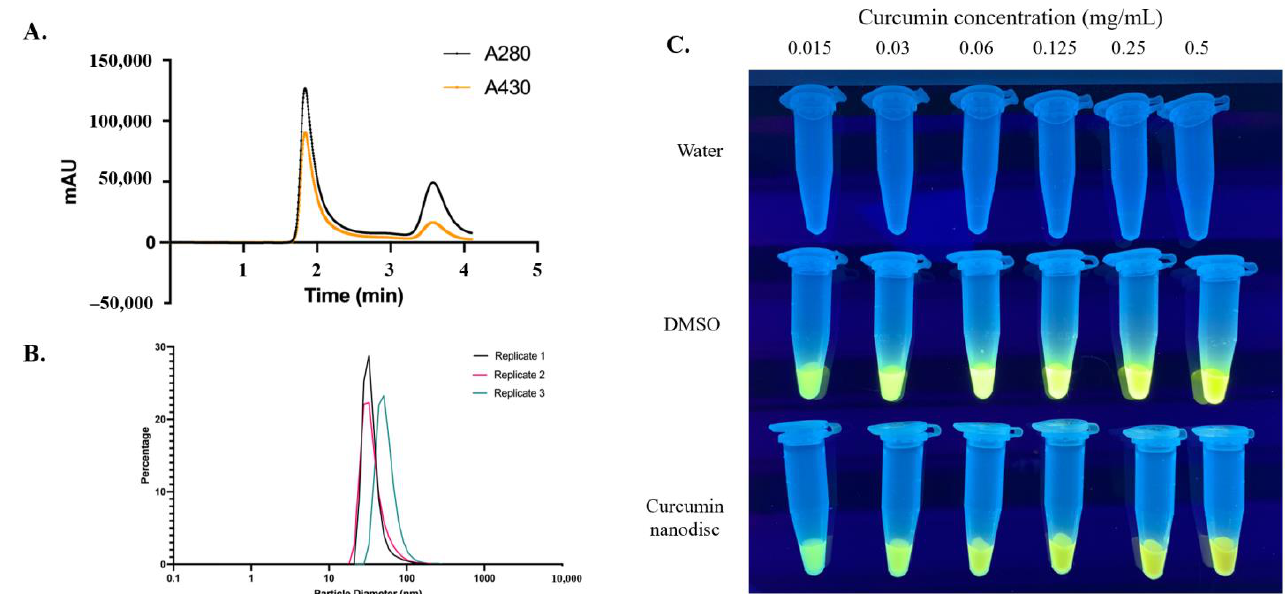
Figure 1. Forming curcumin nanoparticles. Curcumin-DMSO, DMPC, and an amphipathic telodendrimer (green) polymer are mixed to form curcumin-telodendrimer nanodiscs (cur-telodiscs). After cur-telodisc formation, Δ 49ApoA1 protein (blue) is added to form curcumin-apolipoprotein nanodiscs. Removal of DMSO is achieved by dialysis overnight in 1× PBS. The next morning, additional DMPC lipid is added, and the resulting mixture contains solubilized small and large nanodiscs, collectively termed cNLPs.